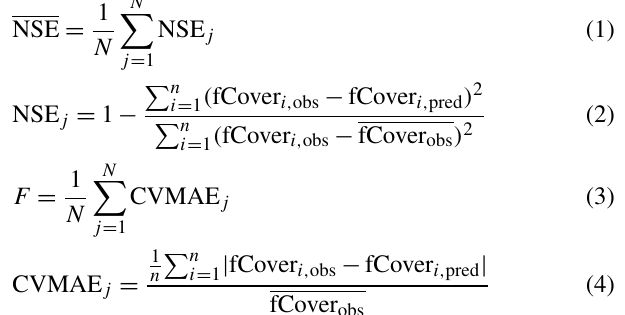
Figure 2. Scaling representation of the 11 model parameterizations. Numbers in parentheses represent the number of sites and site years, respectively. Each model uses a different subset of sites ranging from the entire dataset (all site model) to one vegetation type within an ecoregion (e.g., eastern temperate forest